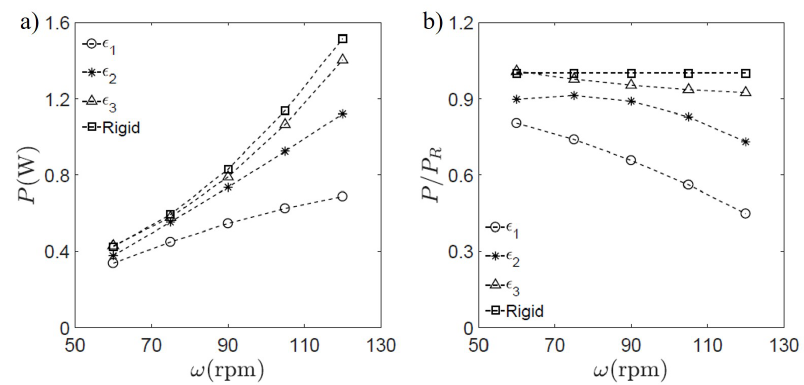
Figure 10. ( a ) Power consumption of the plate rotations across various ω and thicknesses; and ( b ) normalized power with respect to the rigid counterpart